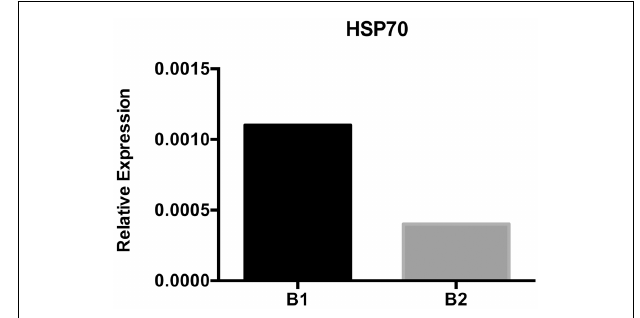
FIGURE 3 | HSP70 expression analysis . Sorted naïve peritoneal B-1a and splenic B-2 cells were used for isolation of mRNA and subsequent cDNA synthesis after DNAse I treatment. HSP70 mRNA expression was assessed using semi-quantitative PCR. Results are representative of three independent